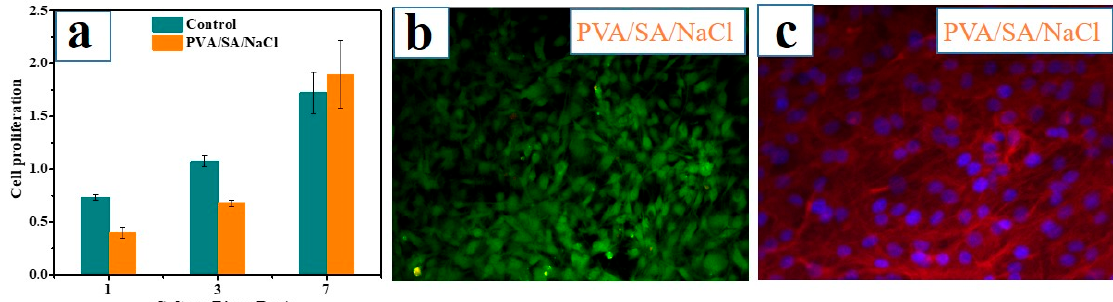
Figure 7. The bioactivity of the PVA/SA/NaCl hydrogel. ( a ) Cell proliferation (OD at 450 nm) of MC3T3-E1 cells after 1, 3, and 7 days of incubation. ( b ) Cell viability assay of MC3T3-E1 cells after incubating for 7 days. Live cells stain green, and dead cells stain red. ( c ) Fluorescent images (red (actin) and blue (nucleus)) of MC3T3-E1 cell morphology after 7 days of incubation on the PVA/SA/NaCl hydrogel. Error bars indicate the standard deviation, and n = 3.